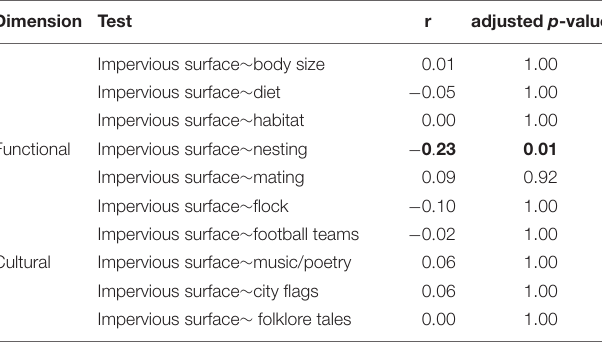
TABLE 3 | Relationships between bird functional traits and cultural values and impervious surface in Campo Grande obtained from fourth corner analysis. Dimension Test r adjusted p